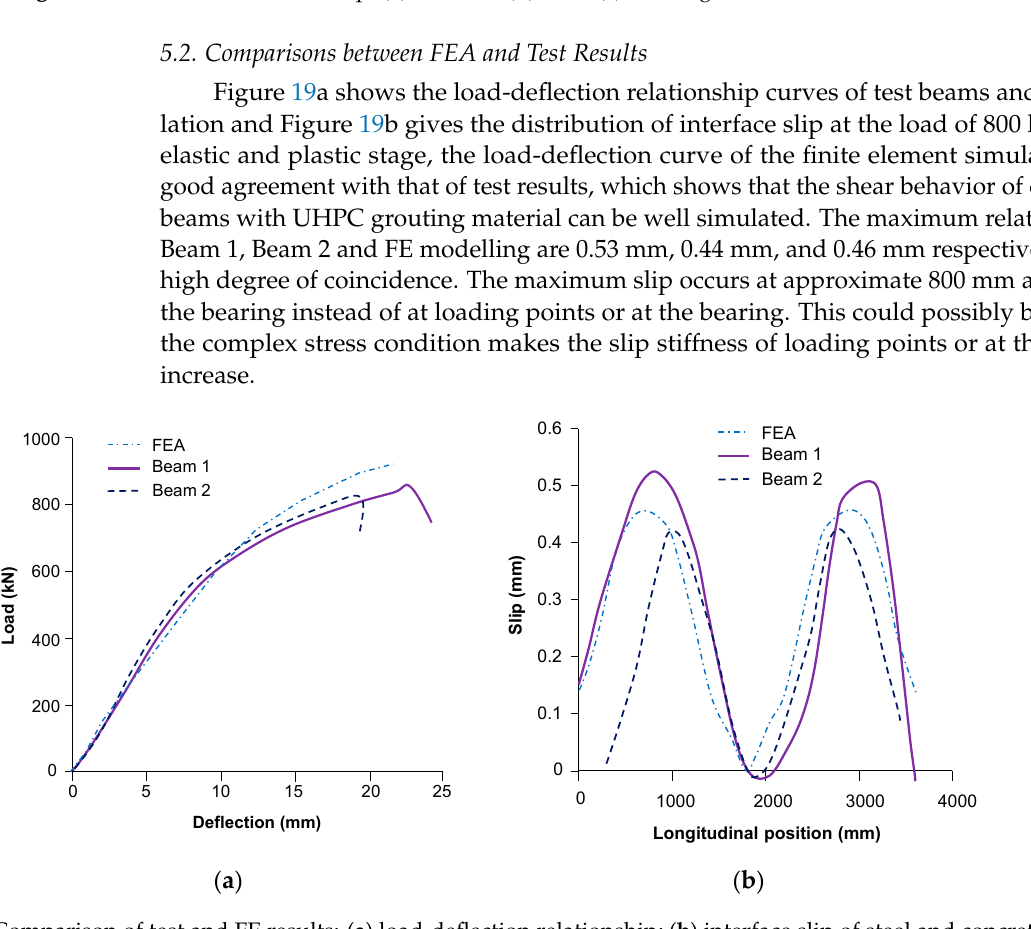
Figure 19. Comparison of test and FE results: ( a ) load-deflection relationship; ( b ) interface slip of steel and concrete at a load of 800 kN.